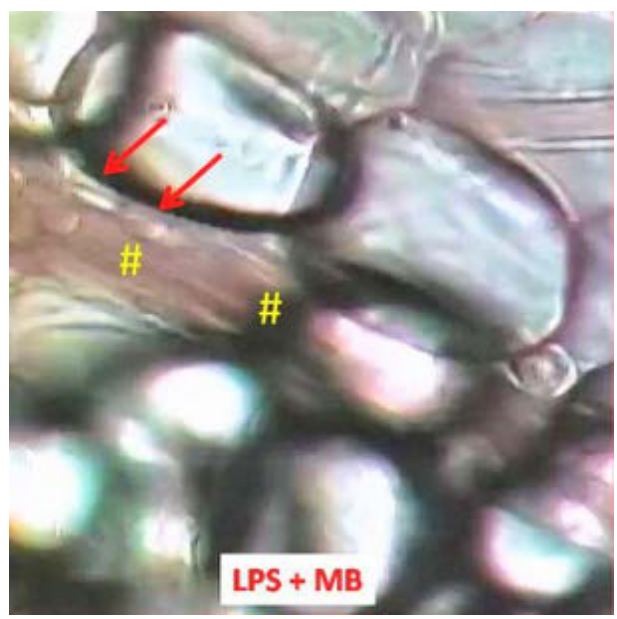
Fig. 6 - Photograph of rat mesenteric microcirculation showing the excellent structure after Escherichia coli lipopolysaccharide injection. The # shows the venula; the arrows show almost normal leukocyte adhesion. LPS=; MB=methylene